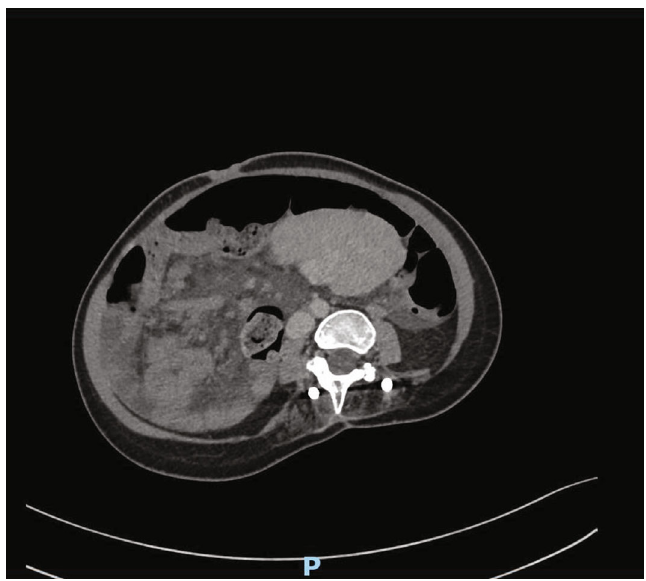
Figure 3: Abnormal position of the spleen in the mesogastric area.